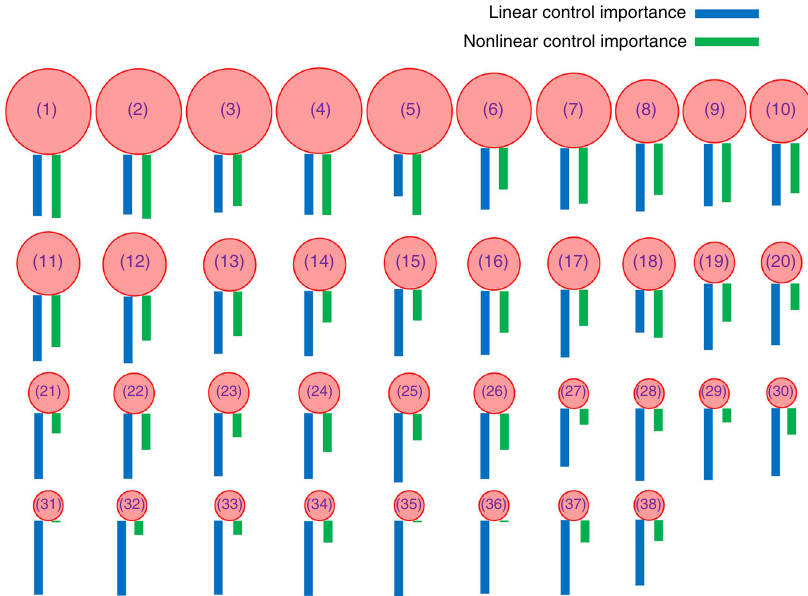
Fig. 1 Distinct characteristics in nonlinear and linear control of a representative complex mutualistic network. The system is network A reconstructed based on empirical data from Tenerife, Canary Islands 67 . The numbers of pollinators, plants, and mutualistic links are N A = 38, N P = 11, and L = 106, respectively. For each node, the species name is given in Supplementary Table 1. The length of the green bar below each species is indicative of the relative importance of the node in tipping point control of the actual nonlinear dynamical network, which is calculated based on Eq. (1). The blue bars illustrate the relative importance of the nodes when the system is arti fi cially treated as a linear, time-invariant network, which are calculated according to Eq. (7). There is great variation in the lengths of the green bars for different species, demonstrating a highly non-uniform nonlinear control importance ranking. In contrast, there is little variation in the length of the blue bars among the different species, indicating an approximately uniform linear control importance ranking.